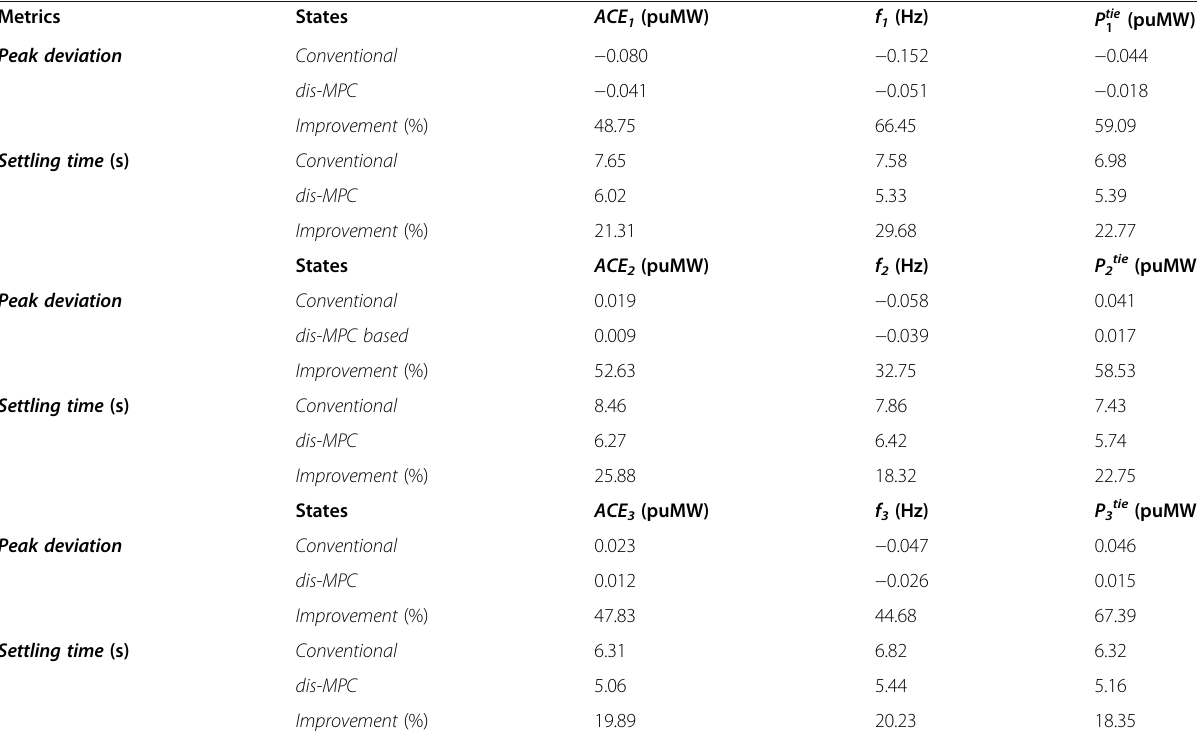
Table 1 Summary of system state responses